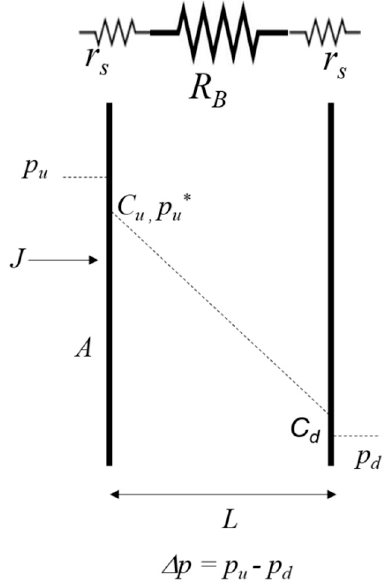
Figure 1. Electric analogy of the permeation process.